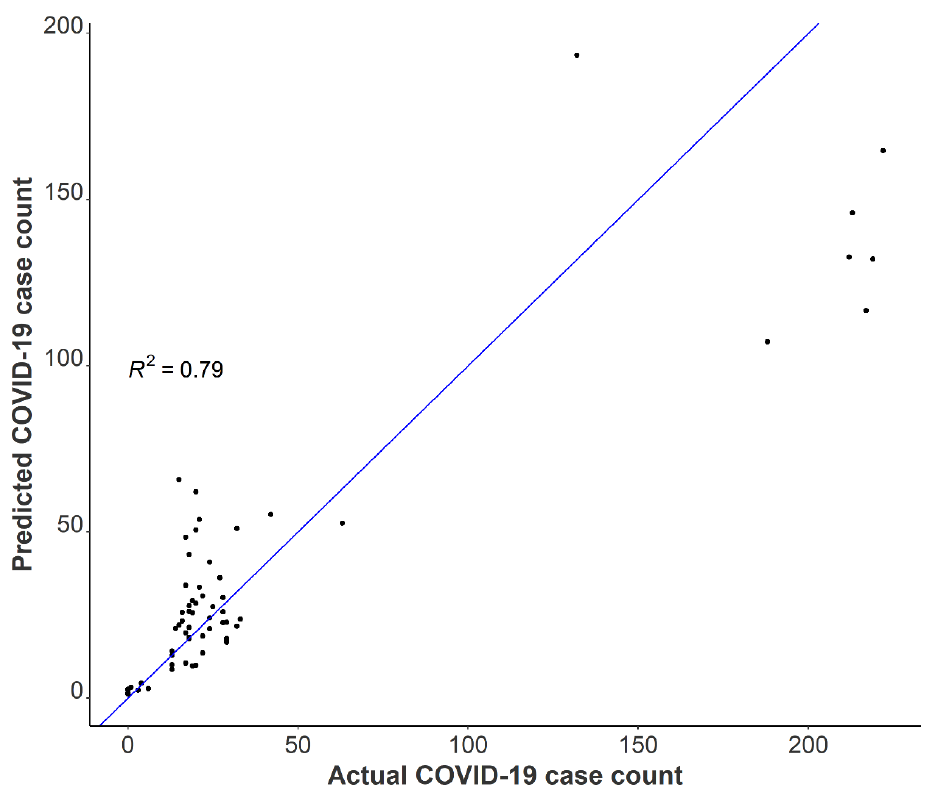
Figure 6. Observed COVID-19 isolation residence occupancy plotted against predicted COVID-19 isolation residence occupancy using negative binomial modeling with Spring 2021